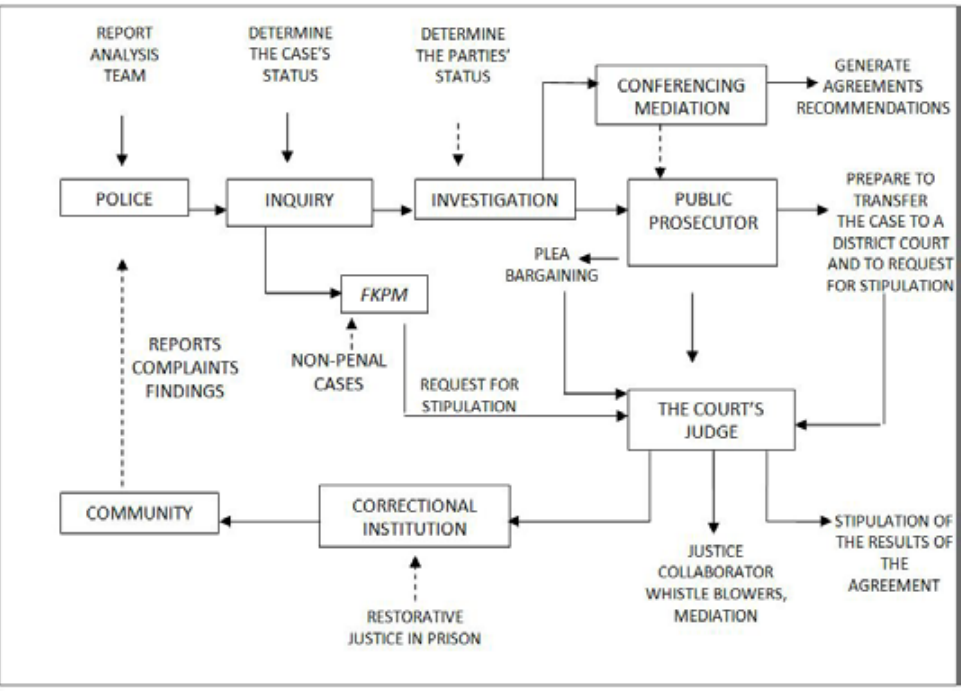
Figure: The construction of the restorative justice Principle in criminal law enforcement (criminal judiciary